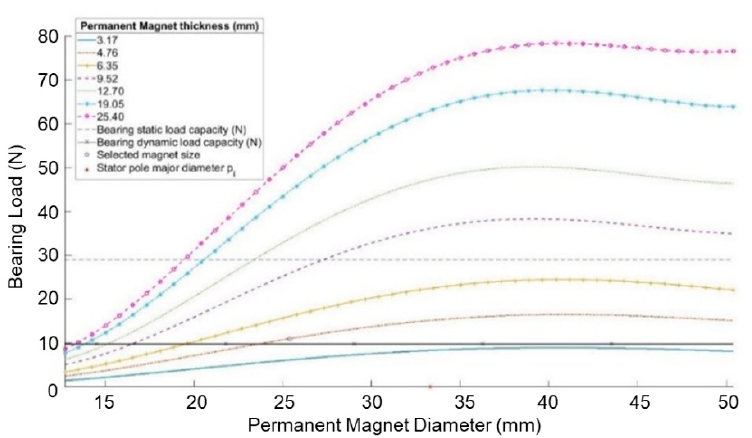
Figure 6. Normal bearing force as functions of diameter and thickness for cylindrical N42 NdFeB PM centered over a stator pole with maximum excitation of 300 Amp-turns. Static and dynamic load capacities for the Hudson bearing (MP-6, NBK, Seki, Gifu, Japan) are indicated.